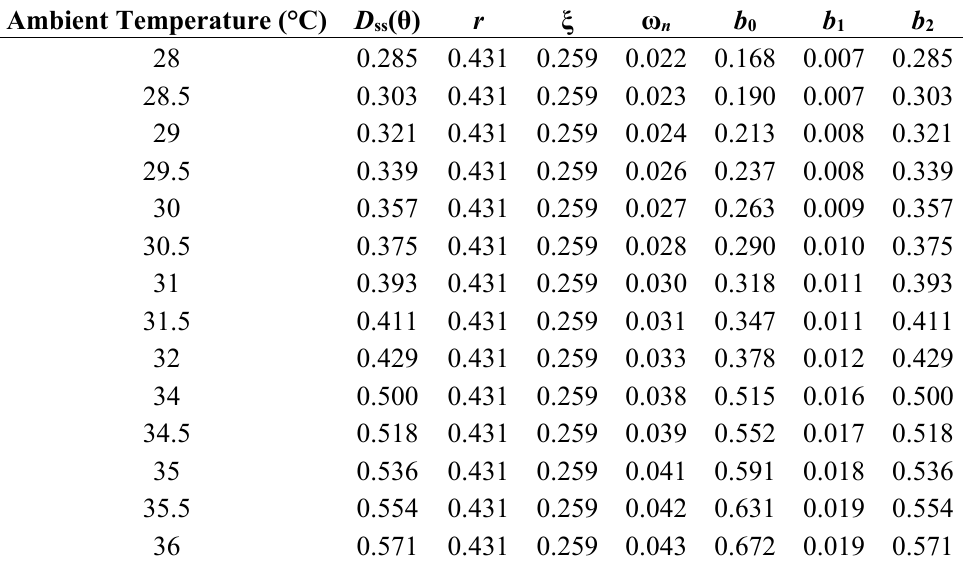
Table 4. Parameters of two order transfer function model for